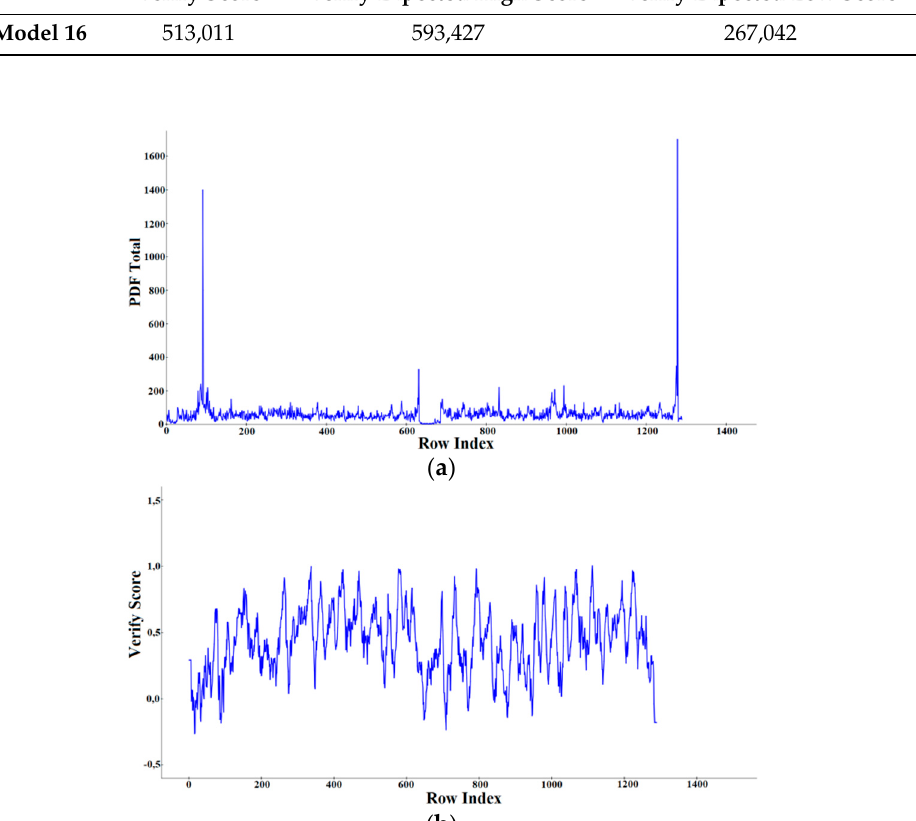
Table 4. Verify Scores of the Model 4 generated by Discovery Studio 4.1 Client / Modeler 9.12 tool.